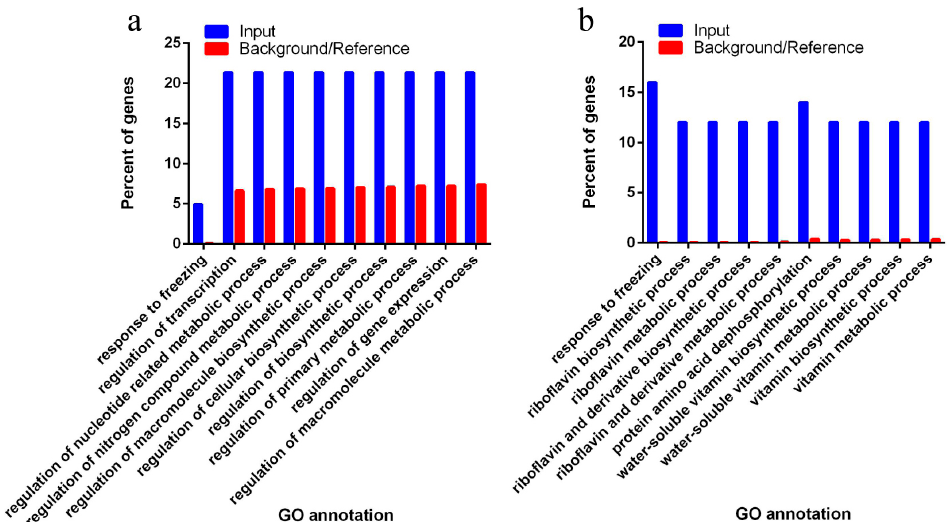
Figure 5. Distributions of differentially expressed miRNA target genes and their functional categories determined by Gene Ontology (GO) analysis. ( a ) Target genes of often highly expressed miRNAs in the embryo. ( b ) Target genes of often highly expressed miRNAs in the endosperm. The x axis represents categories of biological functions in different terms. The y axis is the percentage of genes involved in a certain function. The blue bars represent the percentage of input genes, targets of the differentially expressed miRNAs between the embryo and endosperm with specific functions. The red bars represent the percentage of the control genomic genes that are involved in the specific function of the same category.